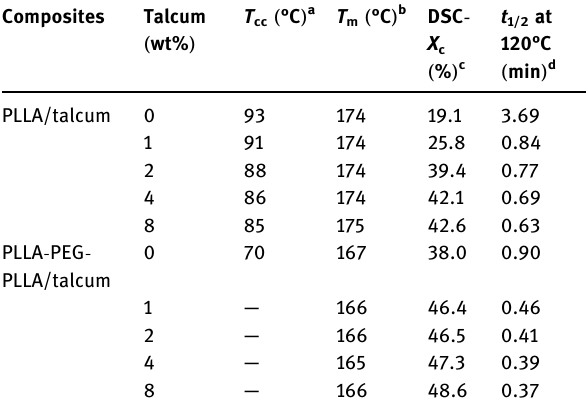
Table 1: DSC results of PLLA/talcum and PLLA - PEG - PLLA/talcum composites Composites